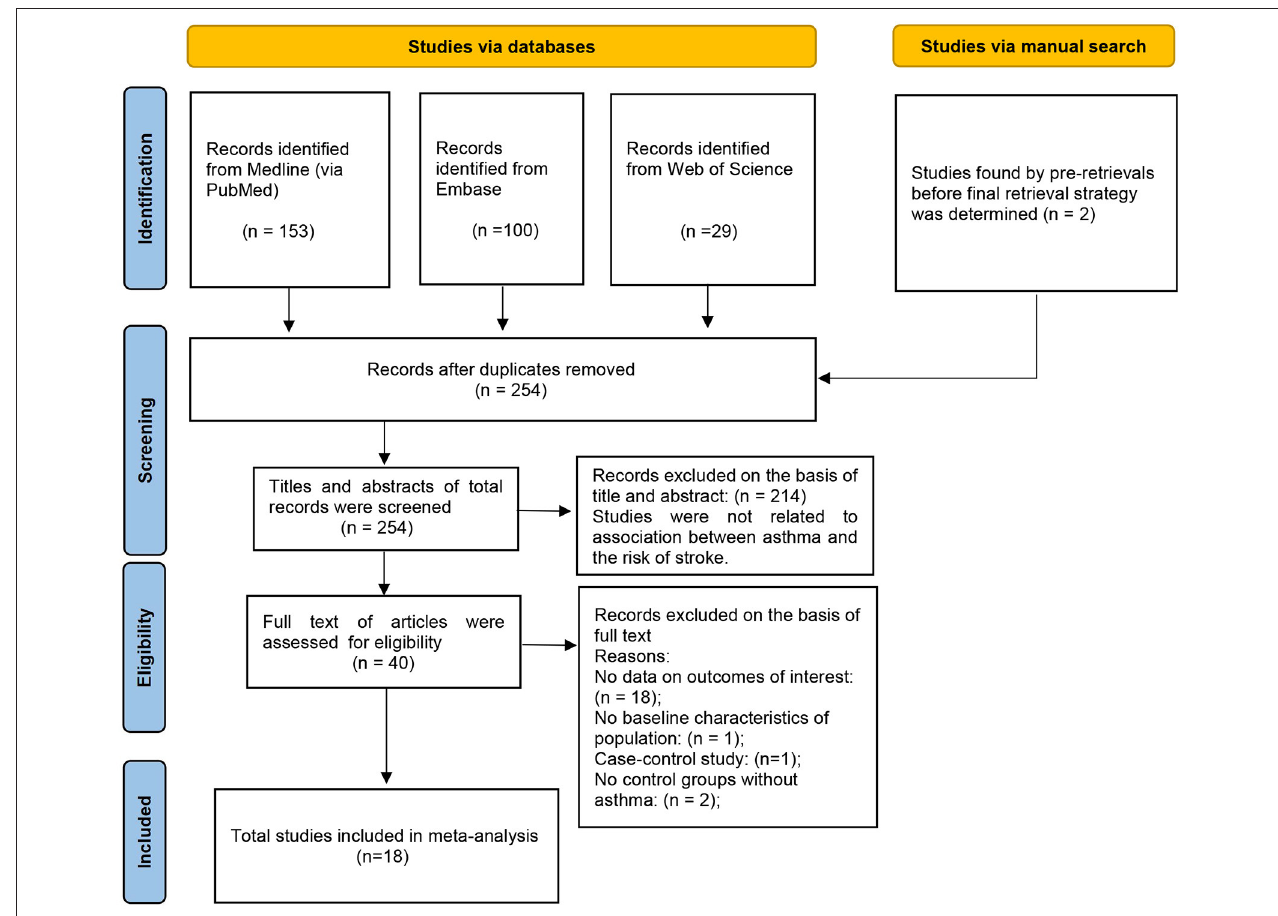
FIGURE 1 | Prisma flow chart of article selection